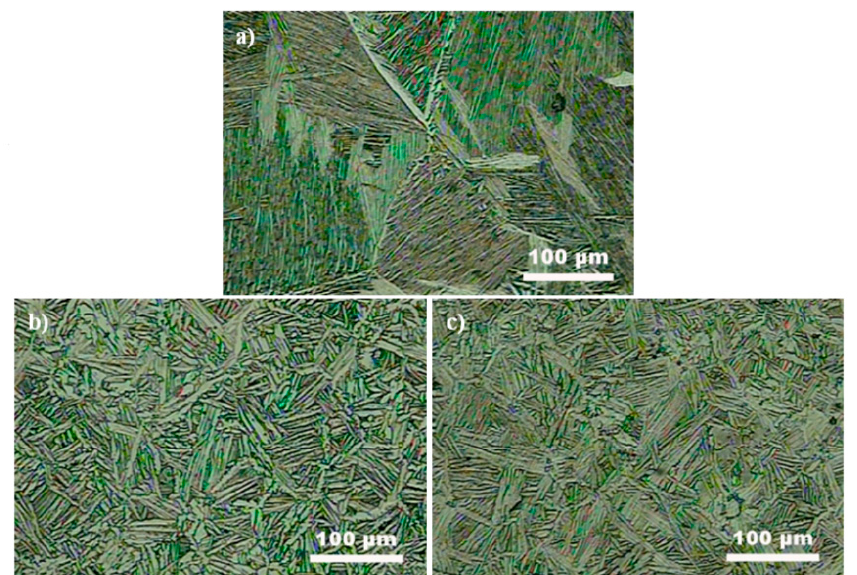
Figure 3. OM images showing typical microstructure of the monolithic TC4 sample ( a ), 0.27GO/TC4 composite ( b ), and 0.54GO/TC4 composite ( c ).